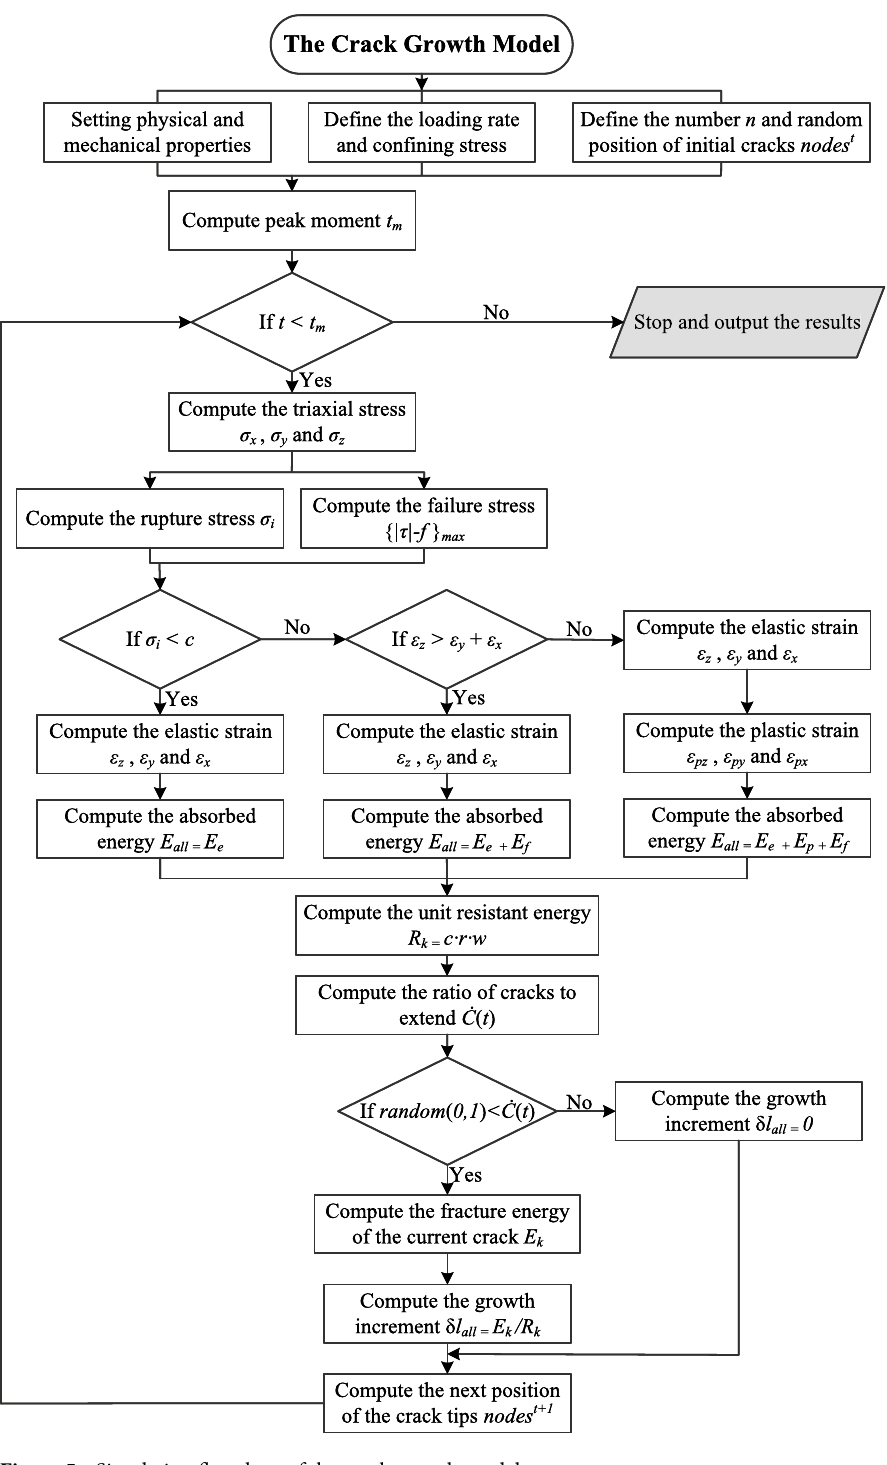
Figure 5. Simulation flowchart of the crack growth